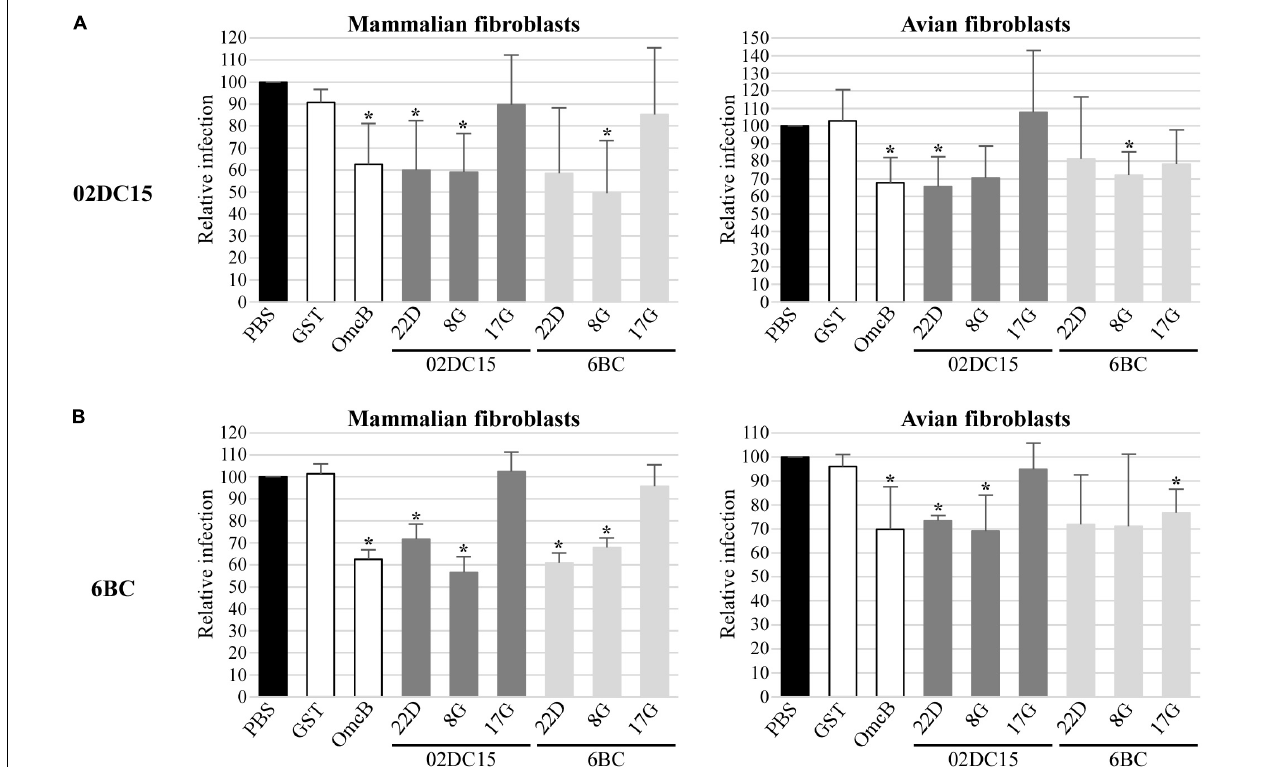
FIGURE 6 | Pmps from mammalian and avian C. psittaci strains show different relevance for C. psittaci infection. Mammalian (McCoy) and avian (UMNSAH/DF-1) fibroblasts were pre-incubated with PBS (black), controls recombinant GST and OmcB (white), or recombinant Pmps from mammalian 02DC15 (dark gray) and avian 6BC (light gray) C. psittaci strains for 1 hour prior to incubation with C. psittaci mammalian 02DC15 (A) or avian 6BC (B) strains. The numbers of inclusions were determined by observation of 10 microscopy fields for each condition. The infection rate for each sample is expressed as a percentage of the relative PBS-treated sample, set to 100%. The relative infection rates represent the mean of three independent experiments ( n = 3). p -values were calculated using paired t -test. * p <